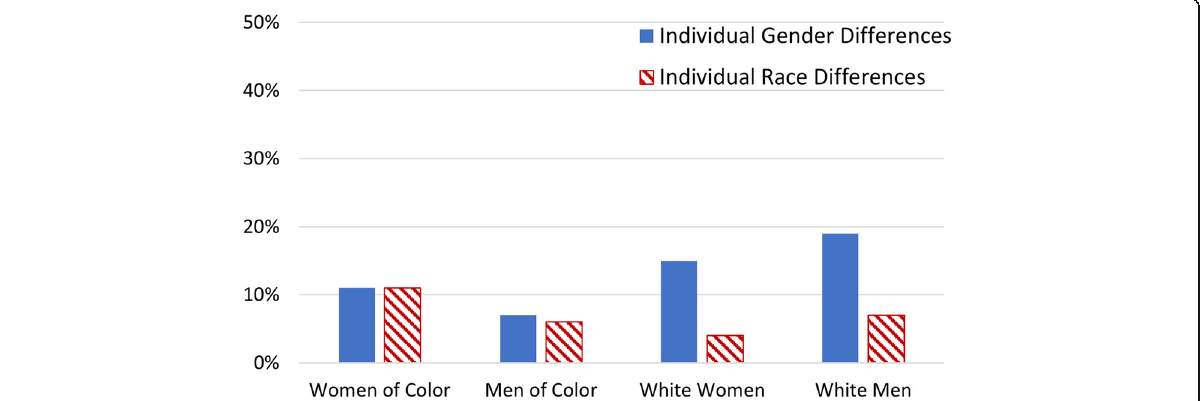
Fig. 3 Percent of respondents who cited individual characteristics as being the cause of gender and race differences in STEM experiences by respondents ’ own race-by-gender